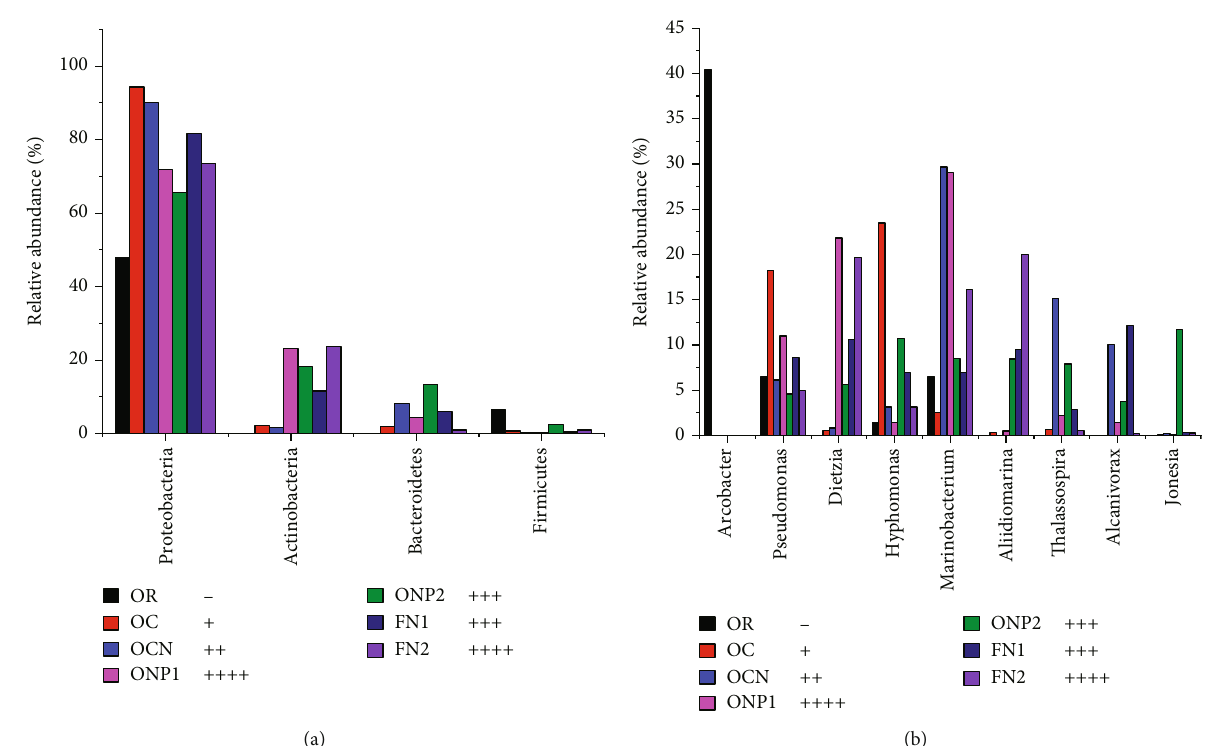
Figure 6: The relative abundances of microbial communities in the six stimulation formulas: (a) the four most abundant phyla; (b) the nine dominant genera.